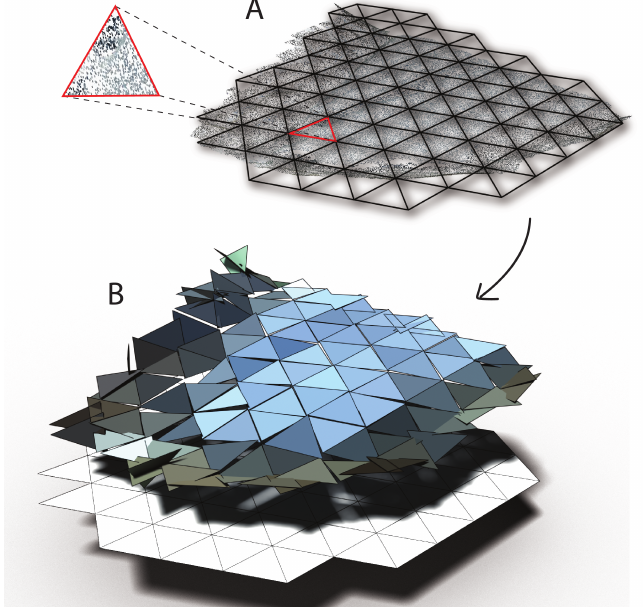
Figure 1. ( A ) The point cloud is approximated in the DGGS by partitioning the points into smaller per- cell point clouds based on their geolocation within the DGGS cells. ( B ) A local planar approximation is calculated for each per-cell point cloud, and the DGGS cell from ( A ) is modified by orienting and translating it to coincide with the planar